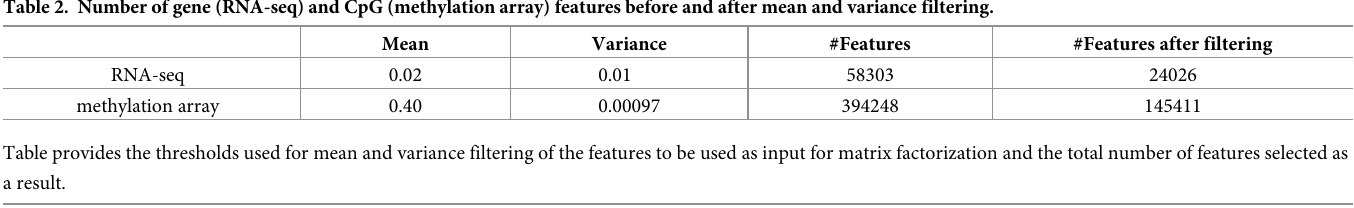
Table 2. Number of gene (RNA-seq) and CpG (methylation array) features before and after mean and variance filtering.